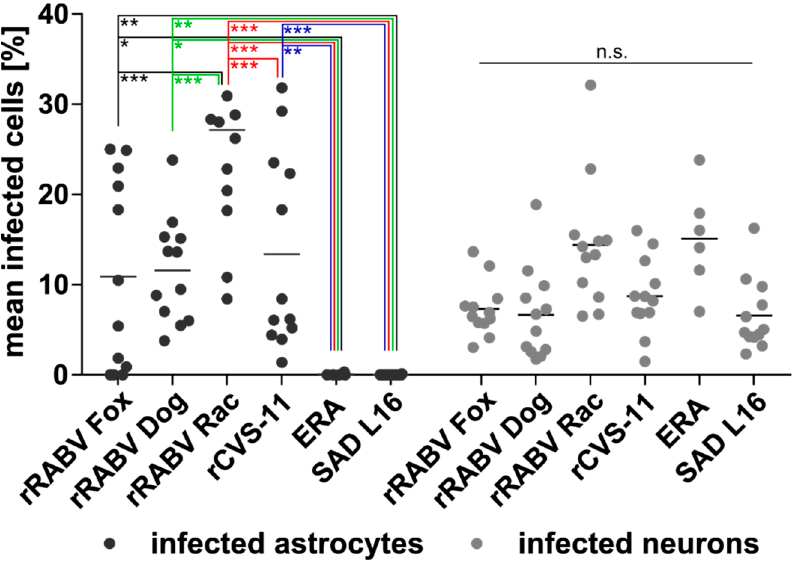
Figure 6. Percentage of field and lab RABV-infected neurons and astrocytes after i.c. inoculation. Per virus, 5 to 9 × 10 3 astrocytes and 1.3 to 3 × 10 4 neurons were counted in 12 (rRABV Dog, rRABV Fox, rRABV Rac, rCVS-11, and SAD L16) and six (ERA) independent confocal z-stacks in two (rRABV Fox, rRABV Dog, rRABV Rac, rCVS-11, and SAD L16) and one (ERA) animal (see Supplementary Table S2). Each dot represents the frequency of infected astrocytes or neurons in an analyzed z-stack. Mean values are provided as horizontal lines. * p ≤ .05; ** p ≤ . 01; *** p ≤ . 001; n.s. = not significant (two-way ANOVA with Tukey’s multiple comparison test).